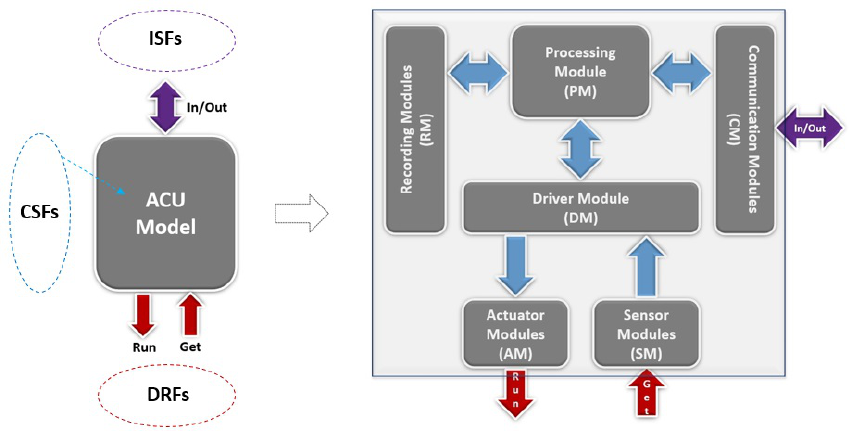
Figure 6. ACUs representation through ‘black box’ and ‘white box’ (external ports and internal